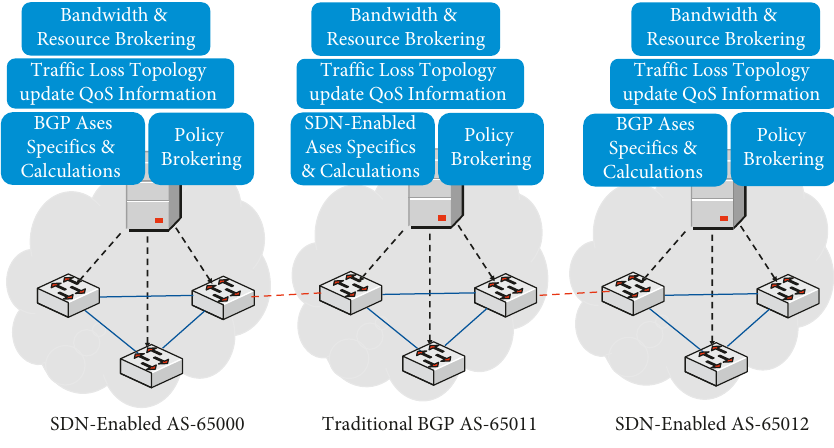
Figure 16: Brokering architecture with 1 BGP-4 and 2 SDN AS